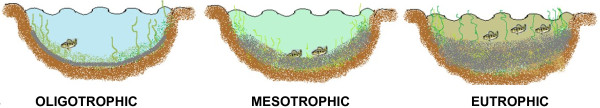
Algal blooms in eutrophic aquatic systems use up nutrients and compete for light. If nutrients become limiting first, microalgae may accumulate large amounts of lipids and/or carbohydrates as a survival strategy. The decay of organic matter by bacteria uses up oxygen causing localized anaerobiosis zones. These zones (here shown as grey areas) are present in all aquatic systems but occur at much deeper levels under mesotrophic or oligotrophic conditions. Photosynthetic microalgae require polar polyunsaturated lipids in particular for membrane where fluidity is critical, while most storage lipid occurs in the form of lipid bodies containing triacylglycerides. These typically vary in their composition and typically contain a mixture of saturated and unsaturated fatty acids for storage.